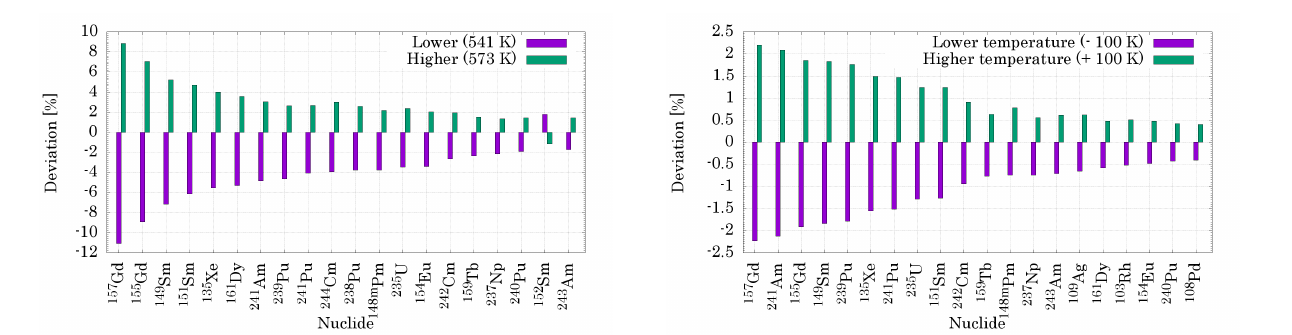
Figure 3. Effect of change in moderator temperature on composition.